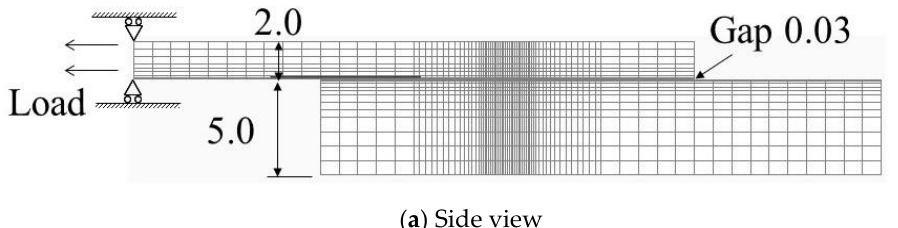
Figure 6. Size and FEM analysis model of the specimen. ( a ) Side view; ( b ) Top view.